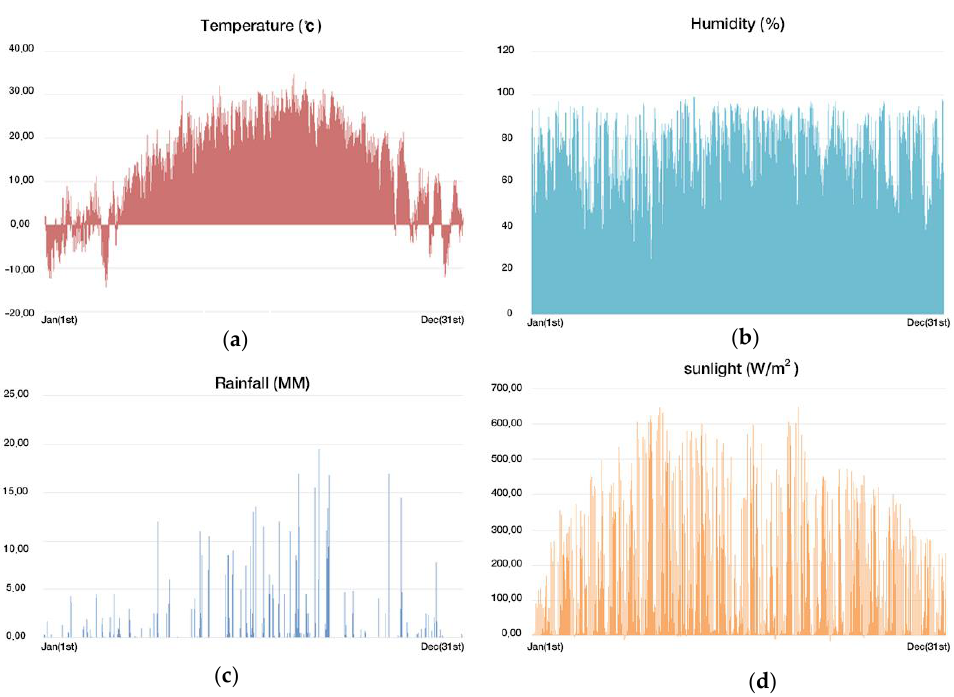
Figure 4. Standard Weather Data in Seoul, Korea [20]: annual values in Seoul for ( a ) temperature; ( b ) humidity; ( c ) rainfall; ( d )